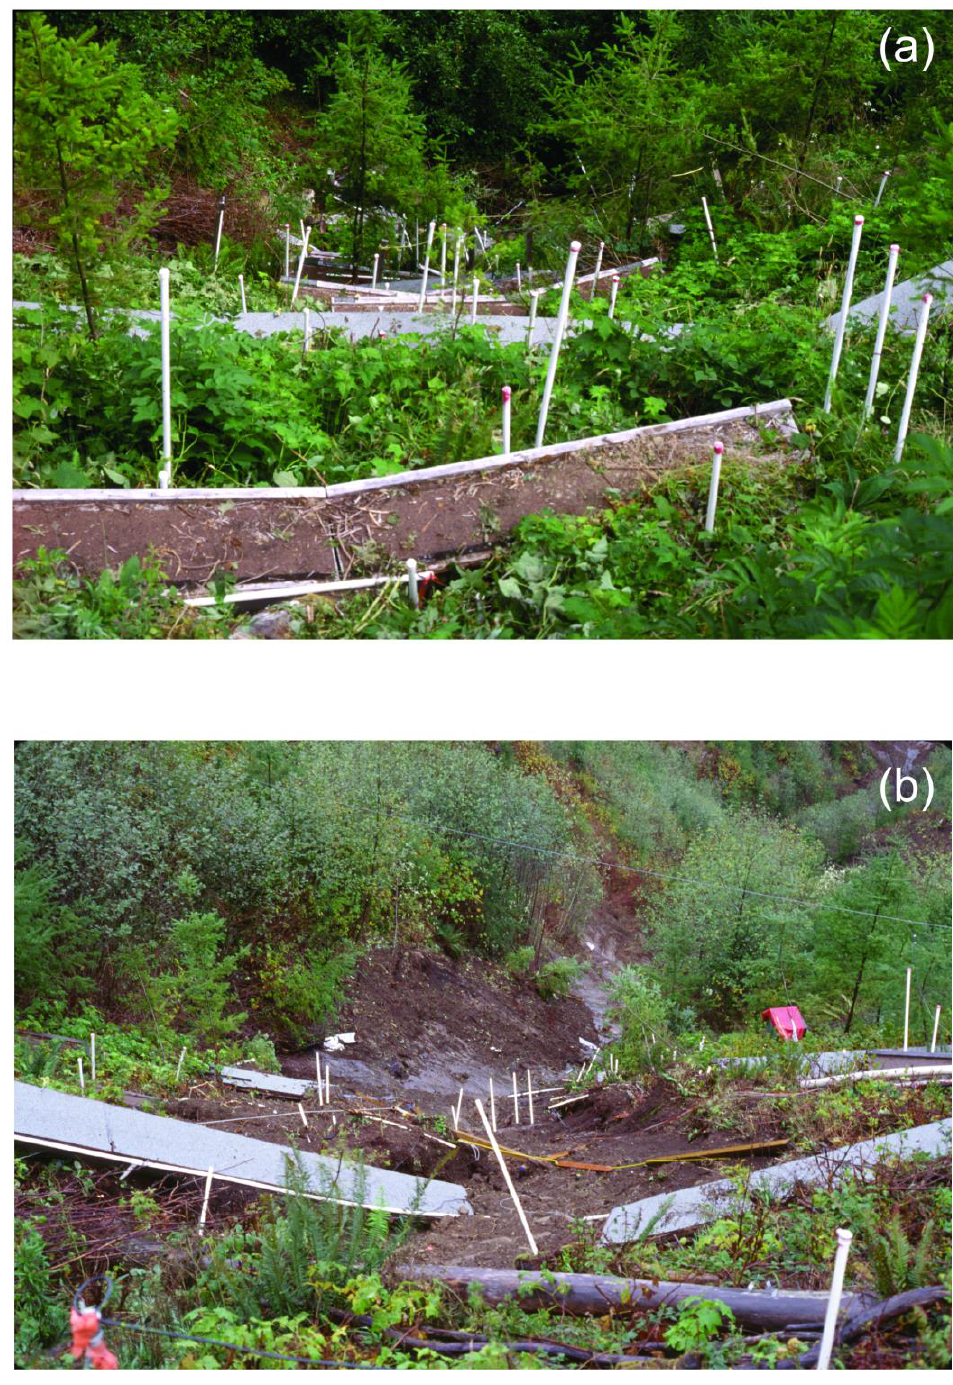
Figure 2. View of the CB1 catchment ( a ) before and ( b ) after the landslide. Both images are taken from the same location at the top of the scarp. The view is to the north, looking directly down the central axis of the hollow. Panel ( a ) shows some of the instrumentation which was installed at the site before the landslide. The instrumentation included tipping bucket rain gages, tensiometers, piezometers, catwalks to minimize ground surface disturbance, and a downslope weir. Photograph by K.M. Schmidt, U.S. Geological Survey.